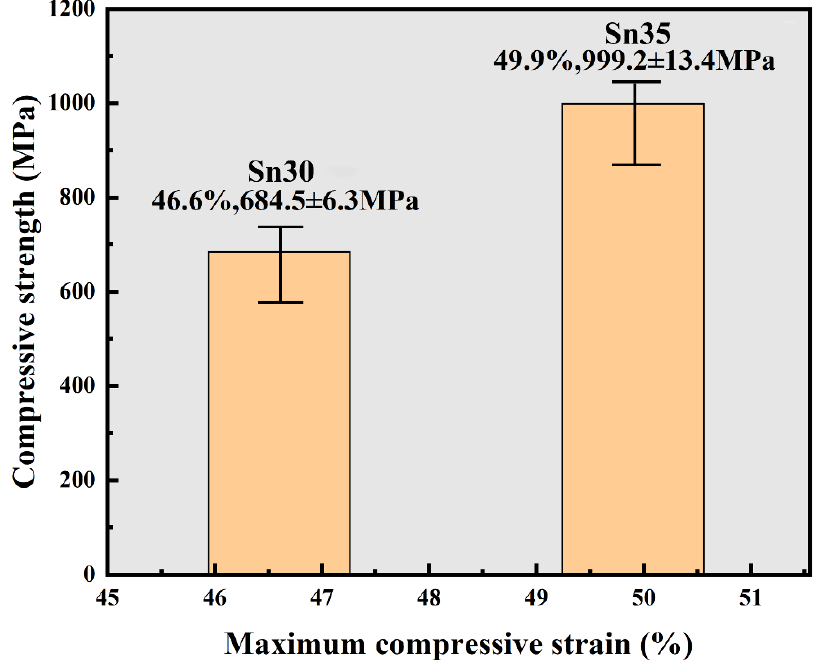
Figure 5. Compression properties of Sn30 BHEA and Sn35 BHEA.